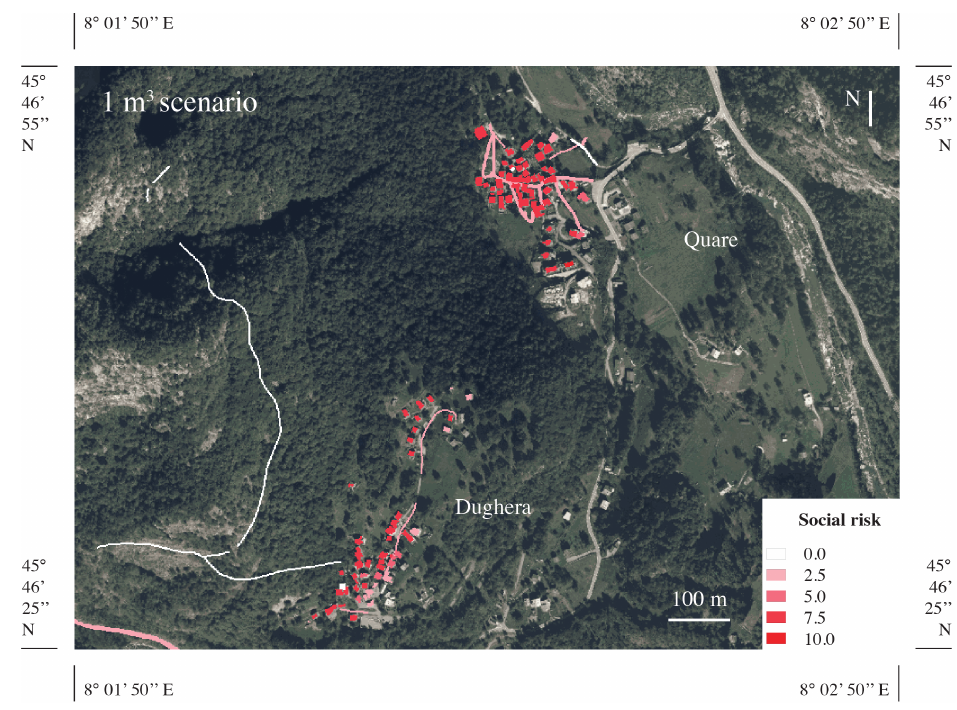
Figure 10. Social risk map for the hamlets of Dughera and Quare, and the 1 m 3 rockfall